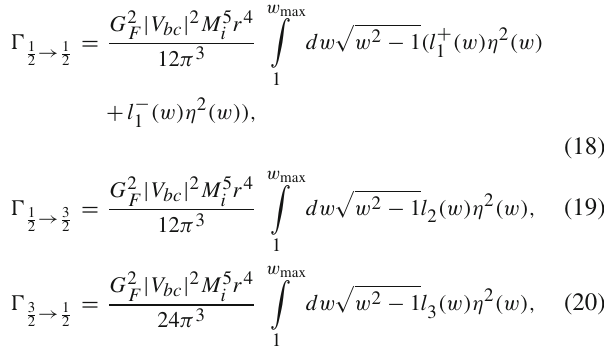
Table 4 Radiative decay width for double heavy baryons (in keV) Decay